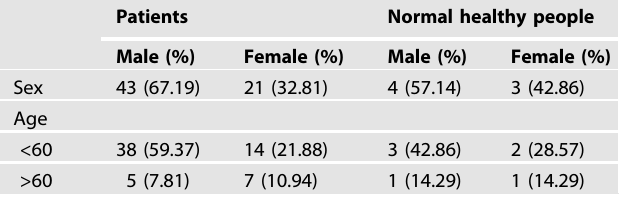
Table 1. The demographical characteristics of normal healthy people and